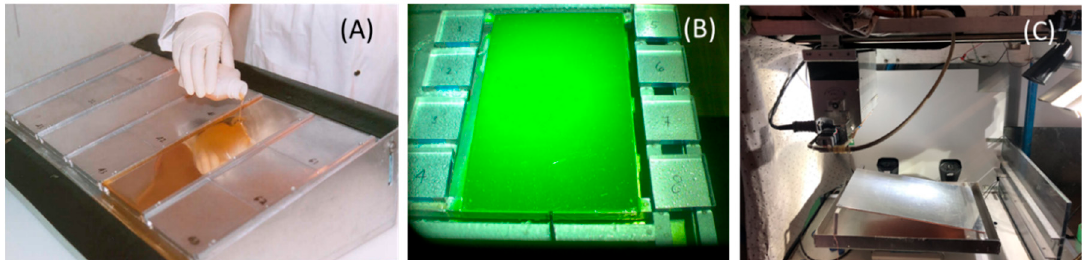
Figure 1. Endurance time tests: ( A ) water spray endurance test (WSET) refrigerated support, ( B ) LZR support plates, and ( C ) Anti-icing Materials International Laboratory (AMIL’s) indoor snow machine.